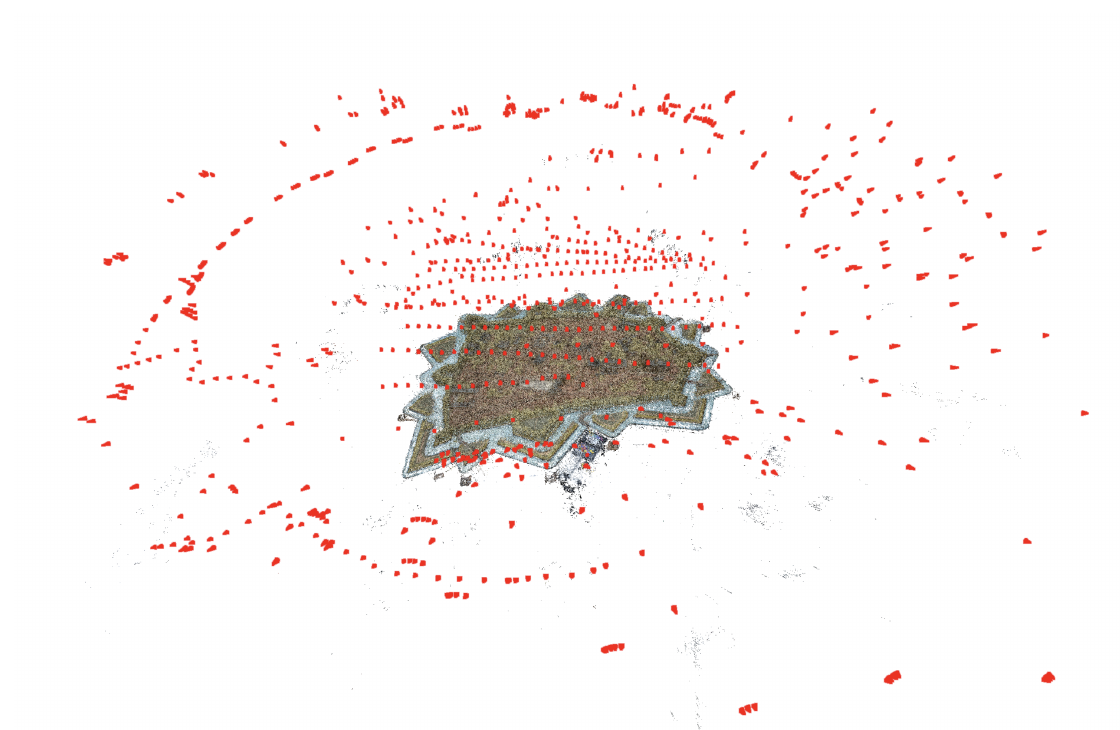
Figure 10. Lys model dataset : current “best-score” of TACO fully automated process on single